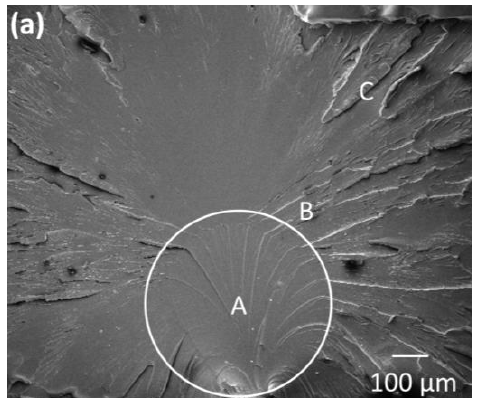
Figure 12. Scanning Electron Micrographs showing the tensile fracture surfaces of ( a ) the neat epoxy; ( b ) 0.3 vol% 20k20k-SiO nanocomposites; ( c ) 1 vol% 20k20k-SiO 2 nanocomposites; ( d ) 0.1 vol% 40k40k-SiO nanocomposites; and ( e ) 0.2 vol% of 2 40k40k-SiO nanocomposites. ‖A‖: mirror zone, ‖B‖: mist zone and ‖C‖: hackle 2